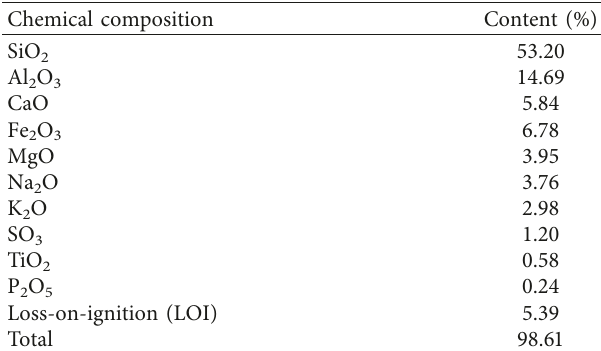
Table 2: Chemical composition of the tailings.